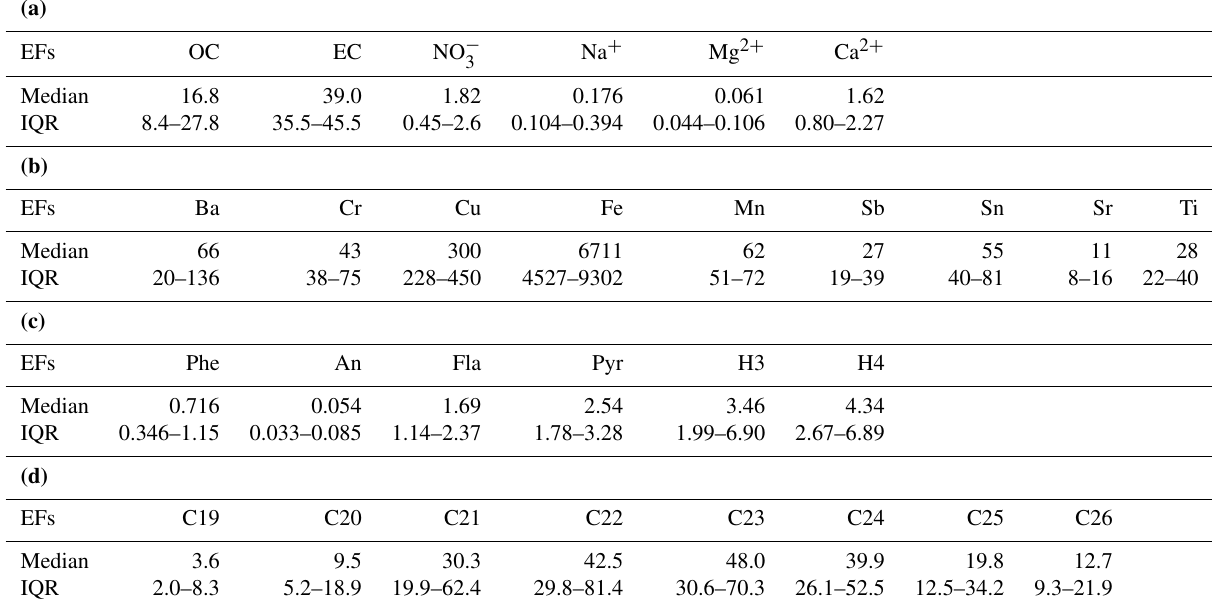
Table 2. (a) Median emission factors for OC, EC and major ions significantly related to traffic and interquartile range (IQR: 25th